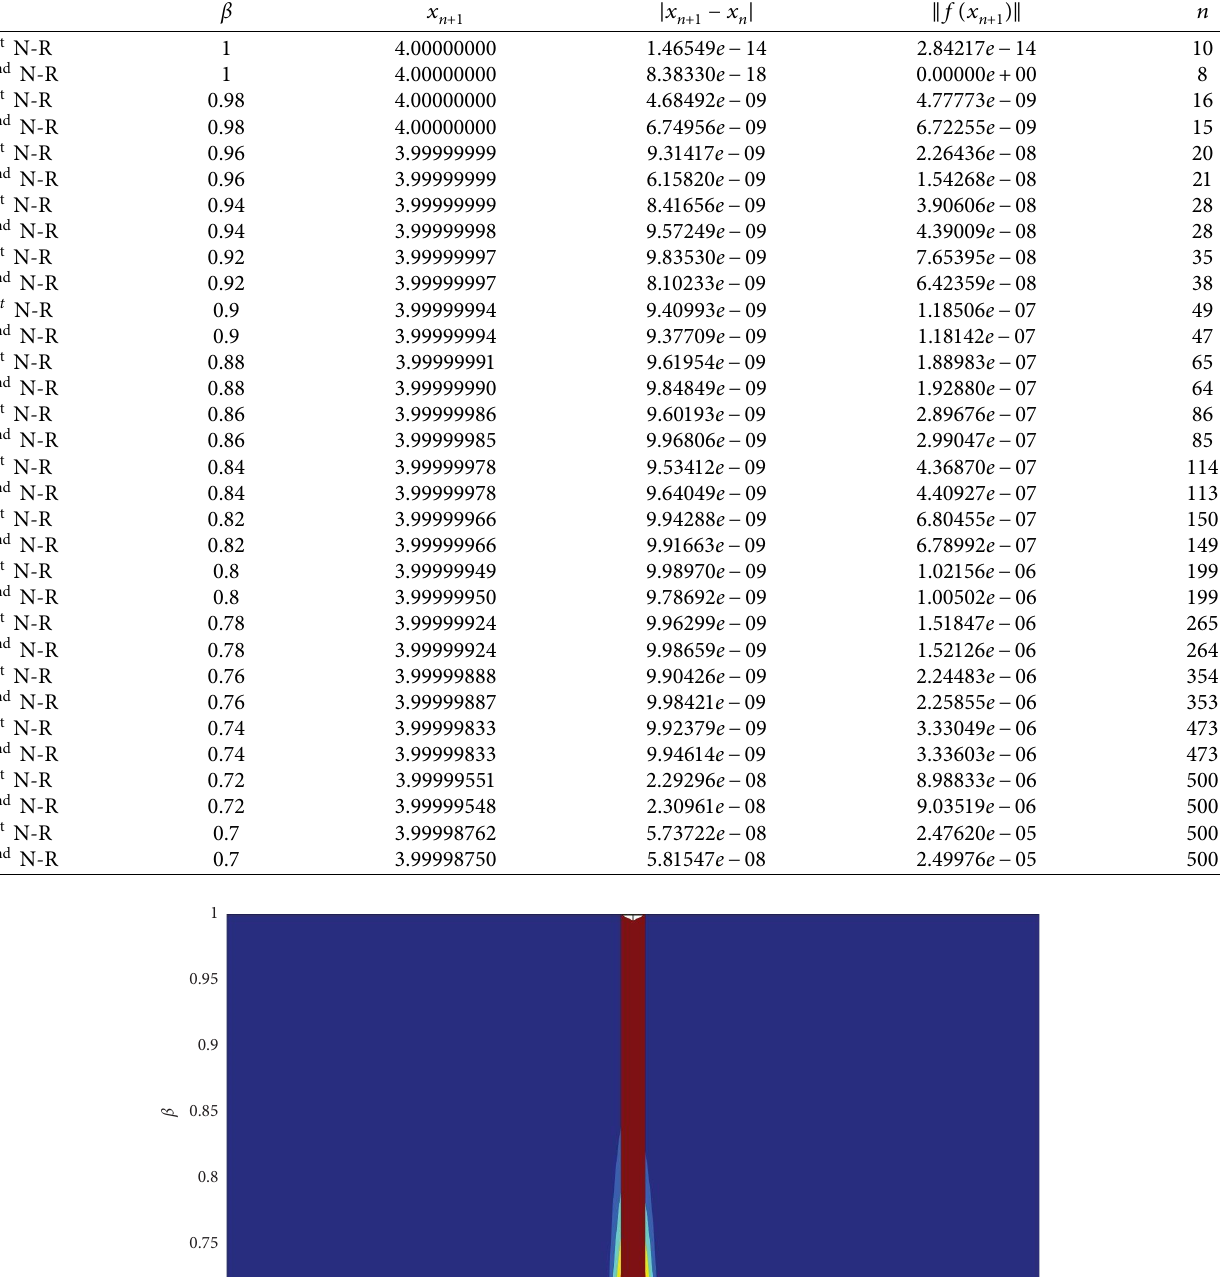
( x ) with Riemann–Liouville derivative and initial estimation x 1